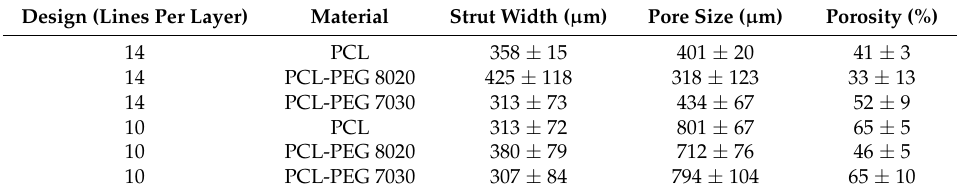
Table 1. Scaffold geometry data for PCL and PCL-PEG blend scaffolds for two different design set- ups using 14 or 10 lines per layer.